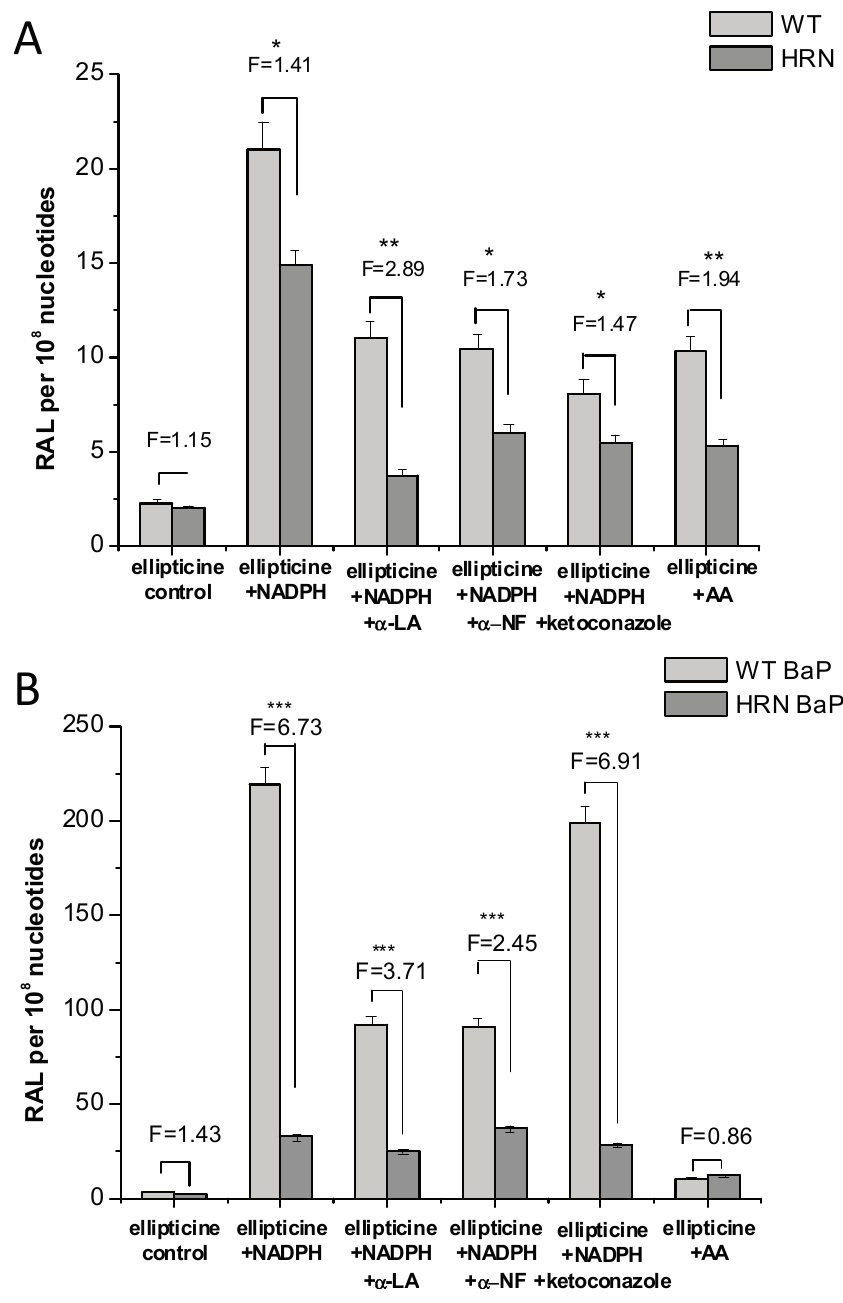
Figure 6. DNA adduct formation by ellipticine activated with microsomes isolated from livers of untreated Hepatic Cytochrome P450 Reductase Null (HRN) or wild-type (WT) mice ( A ) and from mice treated with BaP ( B ) as determined by 32 P-postlabeling. F = fold higher DNA adducts levels in microsomes from WT mice compared to HRN mice. Columns: Mean RAL (relative adduct labeling) ± standard deviations (SD) shown represents total levels of DNA adducts of four determinations (duplicate analyses of two independent in vitro incubations). Values significantly different from HRN mice: * p < 0.05, ** p < 0.01, *** p < 0.001. Control = without cofactor; AA = arachidonic acid; α -NF = α -naphthoflavone; α -LA = α -lipoic